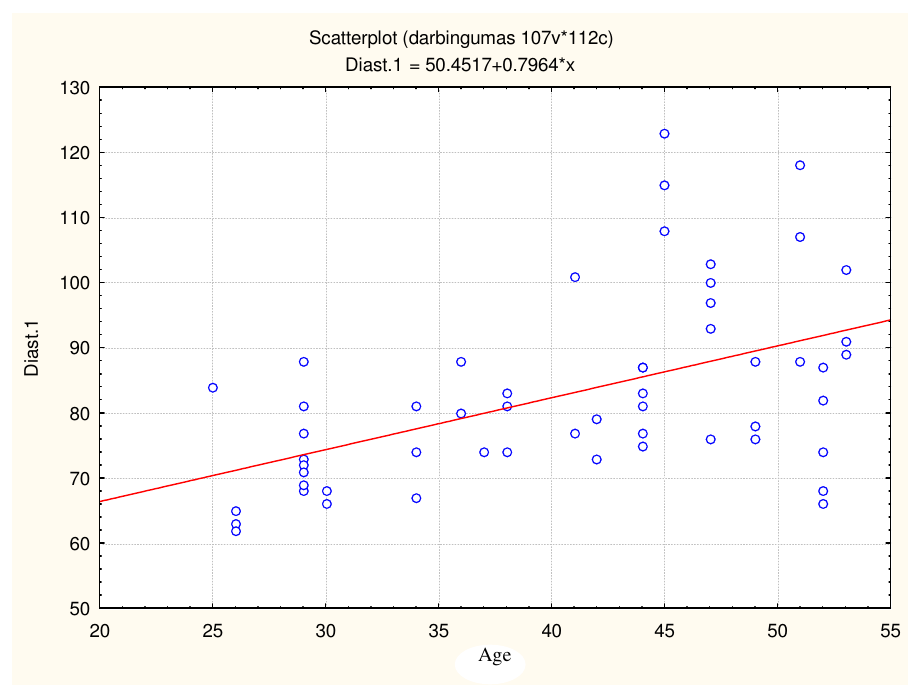
Fig 5. Age and arterial diastolic blood pressure